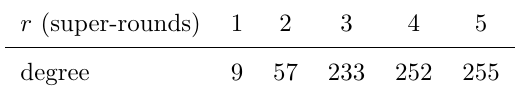
Table 4: Upper-bound on the algebraic degree of Saturnin when the number of super- round